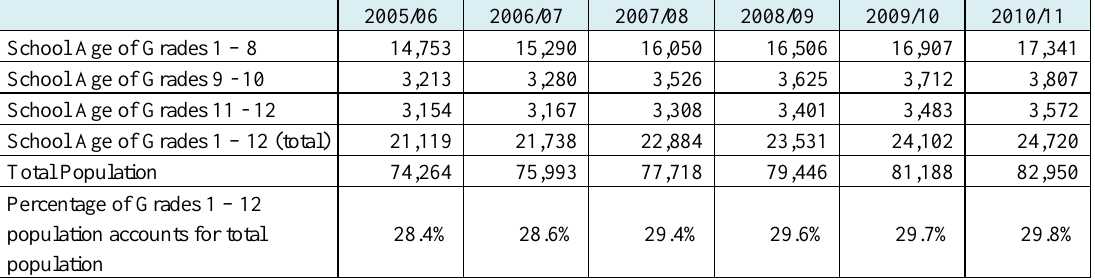
Table 4-1: Transition of School Age Population, 2005/06 - 2010/11